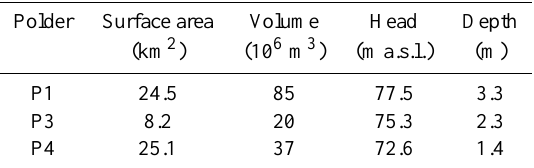
Table 2. Morphological characteristics of polders P1, P3 and P4. Polder